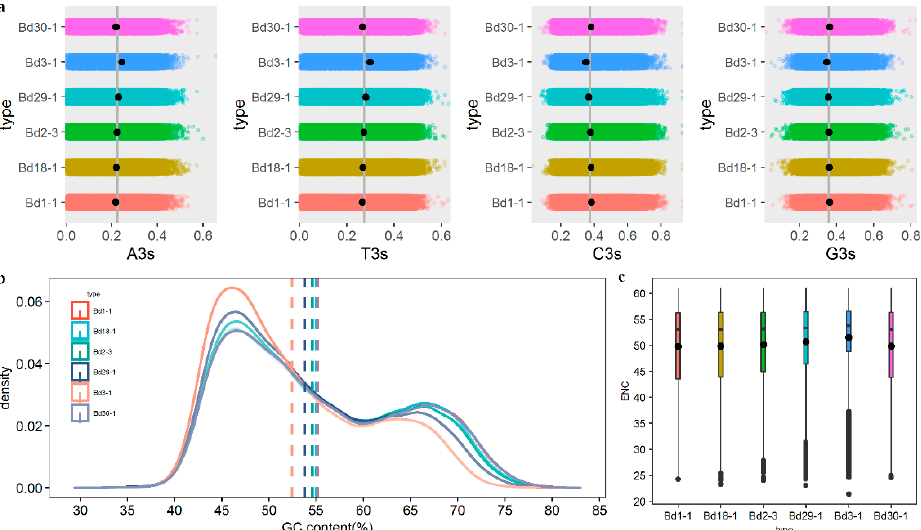
Figure 1. The nucleotide compositions and codon usages of six B. distachyon lines. ( a ) The distribution of four bases at the third positions of the codons; ( b ) The distribution of genes with different GC contents; ( c ) The box plot of ENC values from the six lines.